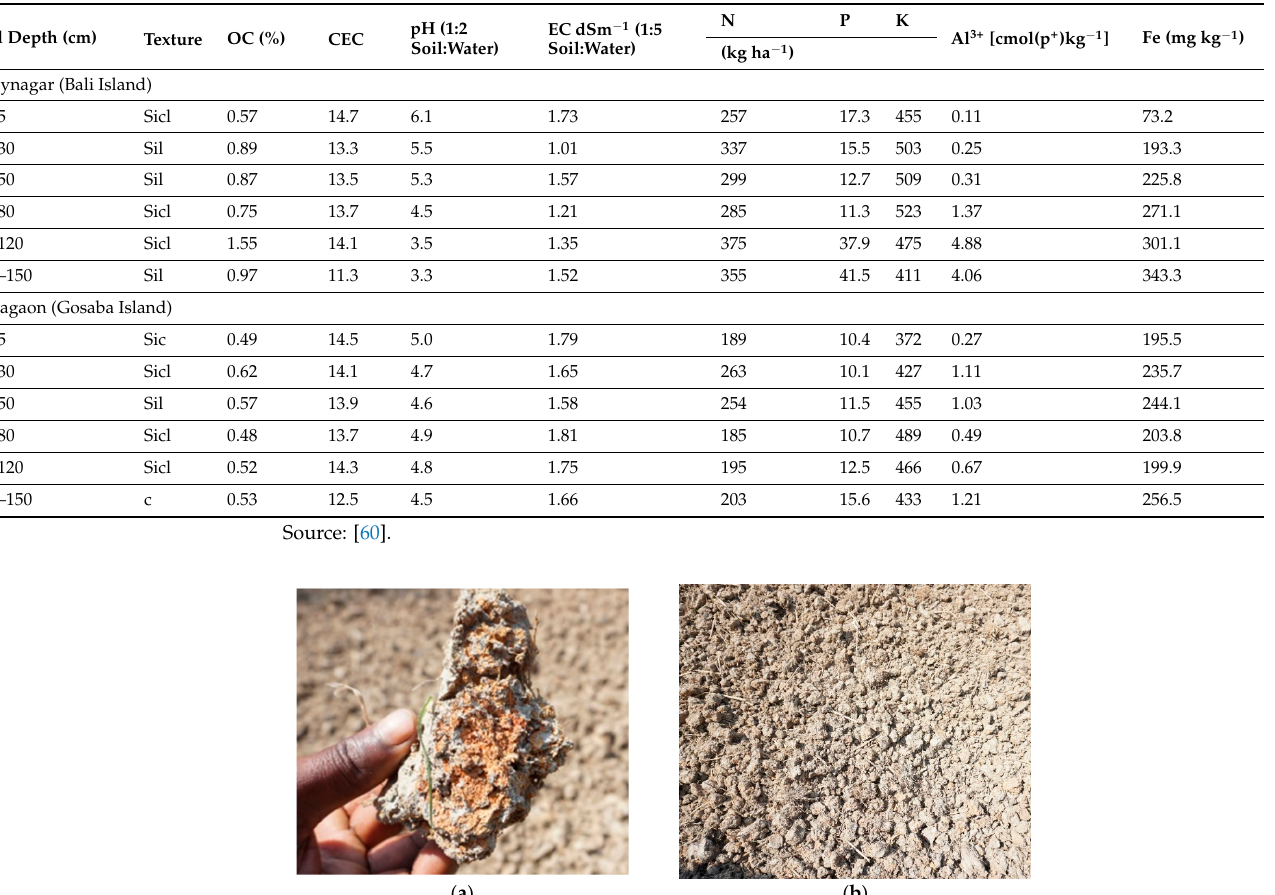
Table 4. Physicochemical properties of acid saline soils of Bijoynager, Bali, Sonagaon, and Gosaba Islands, Sundarbans.